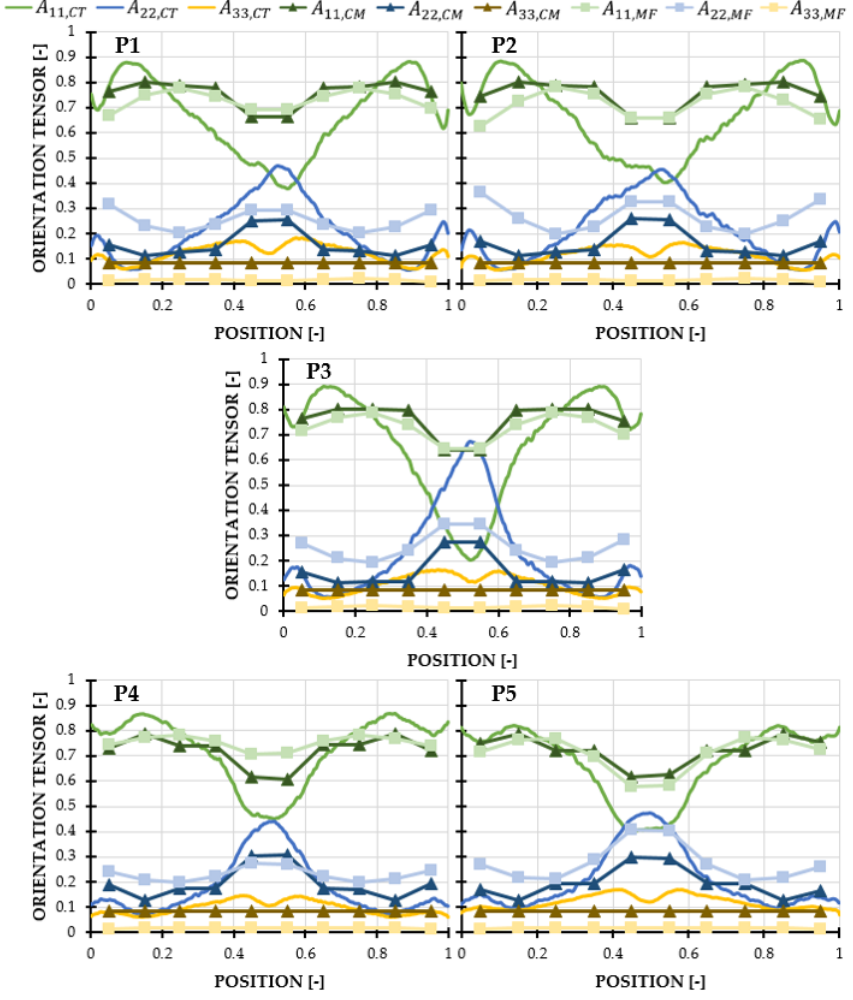
Figure 9. Experimental (CT) and simulative (CM, MF) components of the fiber orientation tensor A ij plotted over normalized position for PPAGF50 at plate level (P1–P5). Table 3. Relative deviation of the averaged orientation tensors from experiment A ij , CT and simulation